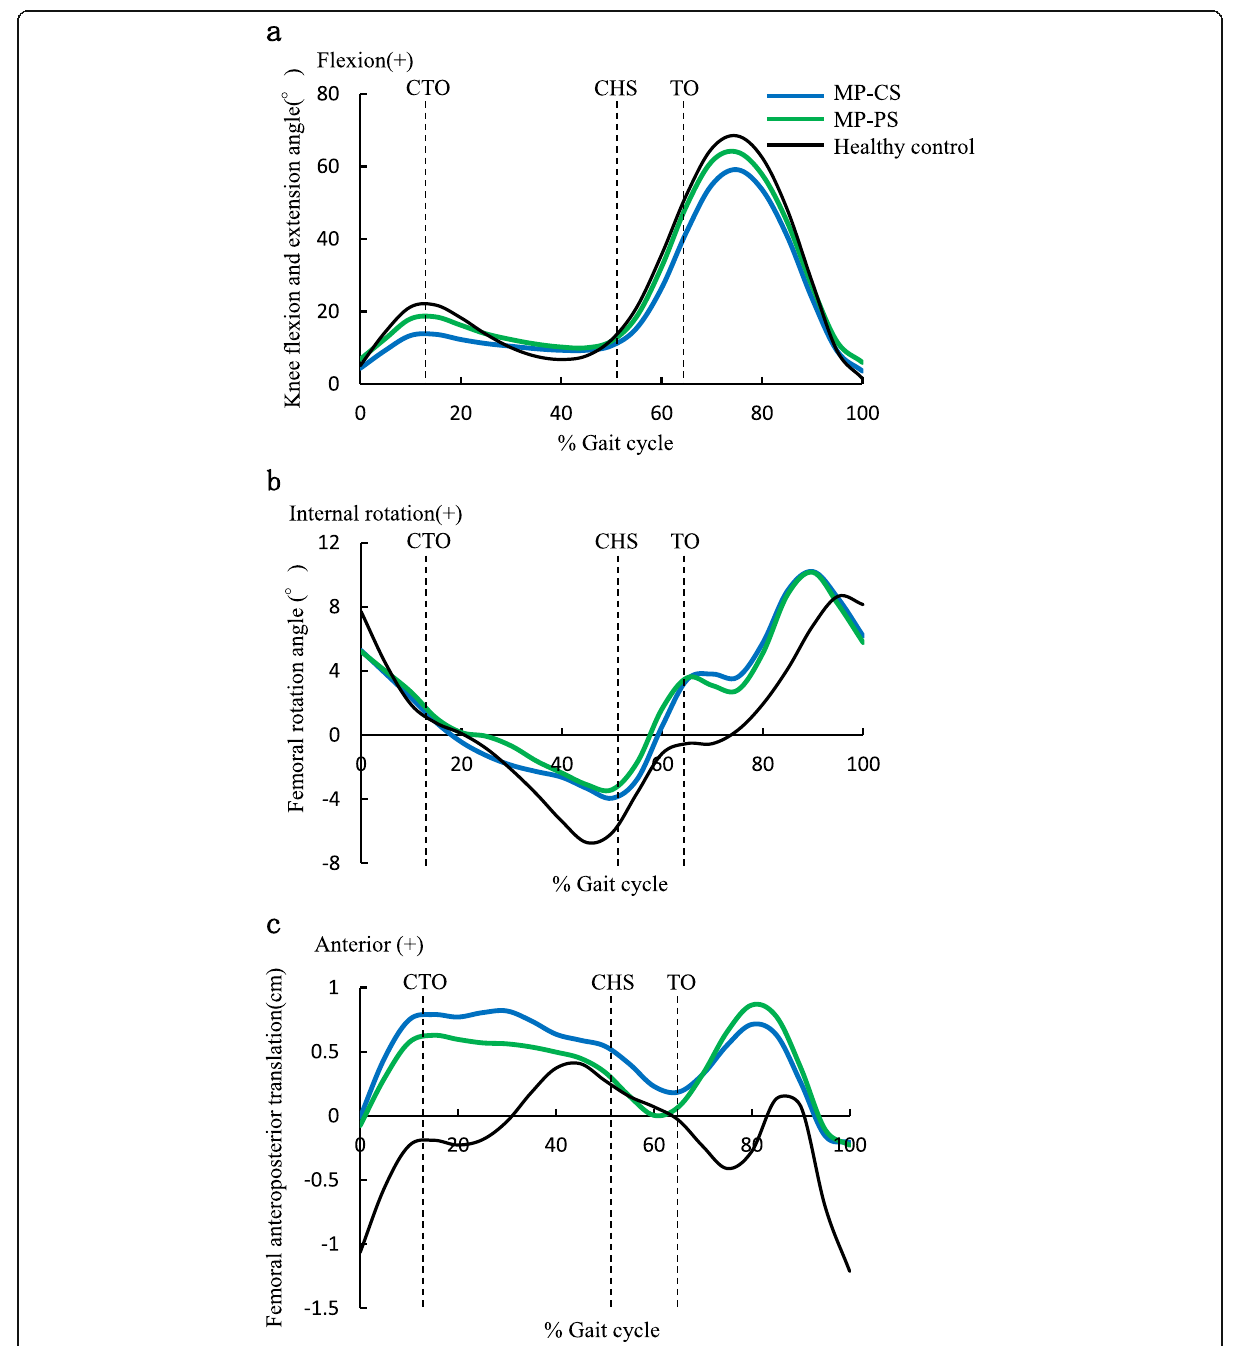
Fig. 2 Kinematics of the knee joint during walking. All three groups showed knee flexion twice during one walking cycle and external rotation in stance phase ( a , b ). In both the MP-CS and the MP-PS groups, the femur showed anterior translation during early stance phase, maintained the anterior position during mid-stance phase, and showed posterior translation during late stance phase to pre-swing phase ( c ). CTO, contralateral toe-off; CHS, contralateral heel strike; TO, toe-off; MP, medial pivot; CS, cruciate-substituting; PS,